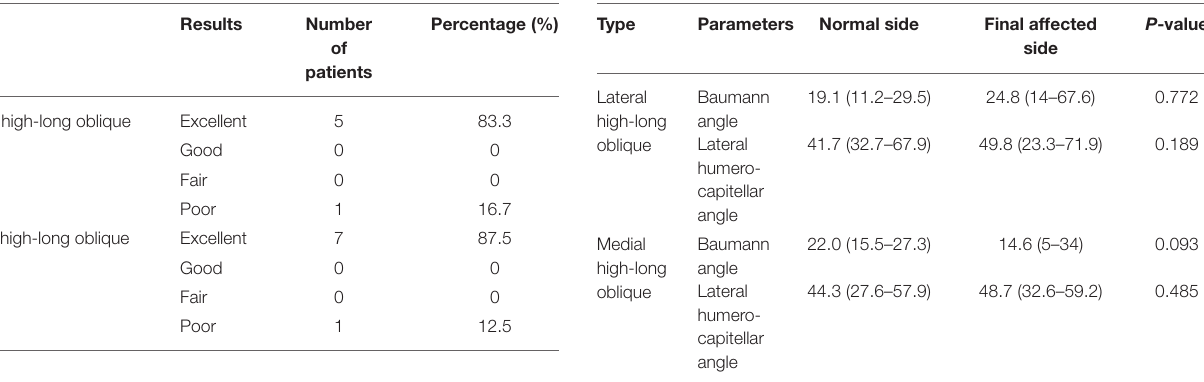
TABLE 2 | Clinical results (according to Flynn’s criteria) for both fracture subtypes. TABLE 3 | Radiological parameters for both fracture